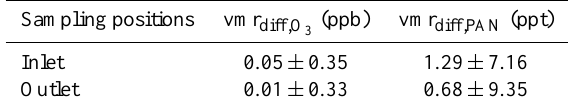
Figure 5. Comparison of the all key parameters between both empty cuvettes to indicate their identity. (a) O 3 mixing ratio, (b) PAN mix- ing ratio, (c) CO 2 mixing ratio, green line: inlet position of the ref- erence cuvette; orange line: inlet position of the sample cuvette; red line: outlet position of the reference cuvette; blue line: outlet posi- tion of the sample cuvette; (d) cuvette inner temperature, reference cuvette (red) and sample cuvette (blue). The colored area represents the uncertainty of the calculated mean values over an average time period of 10min. Table 2. Minimal resoluble mixing ratio difference of O 3 and PAN between both